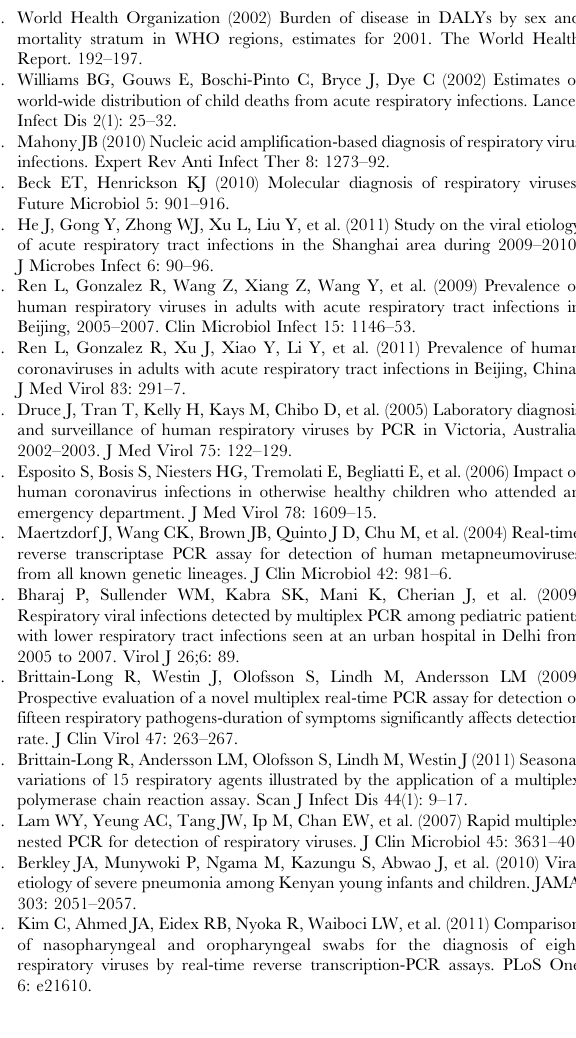
table description, and a non-normal distribution of measurement data using the median to describe the central tendency and percentiles to describe the discrete tendency. The group